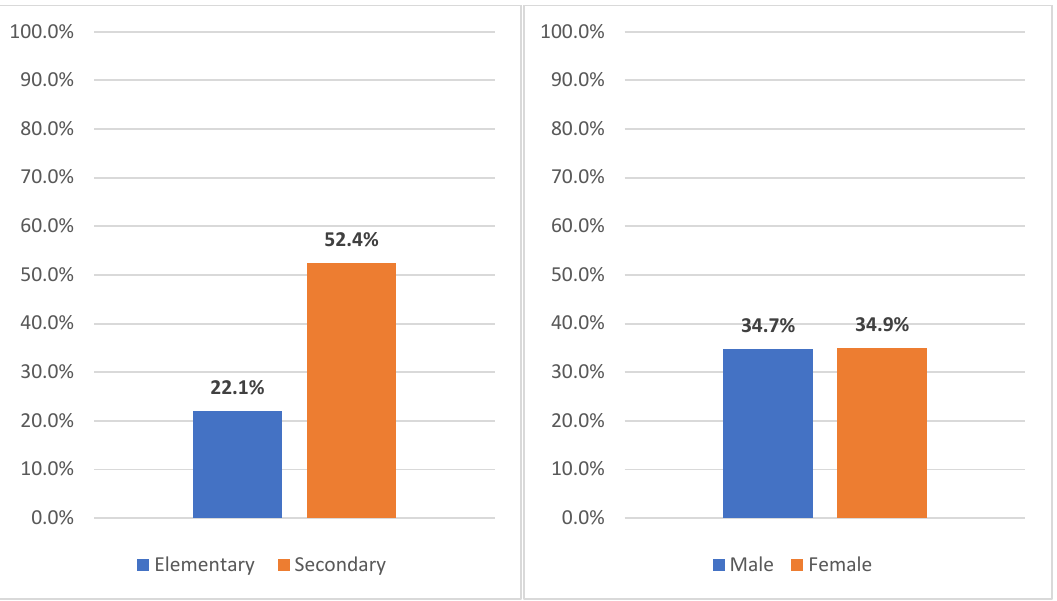
Figure 2. Proportion of elementary and secondary students ever buying lunch at a fast food restaurant/take-out during the school day.